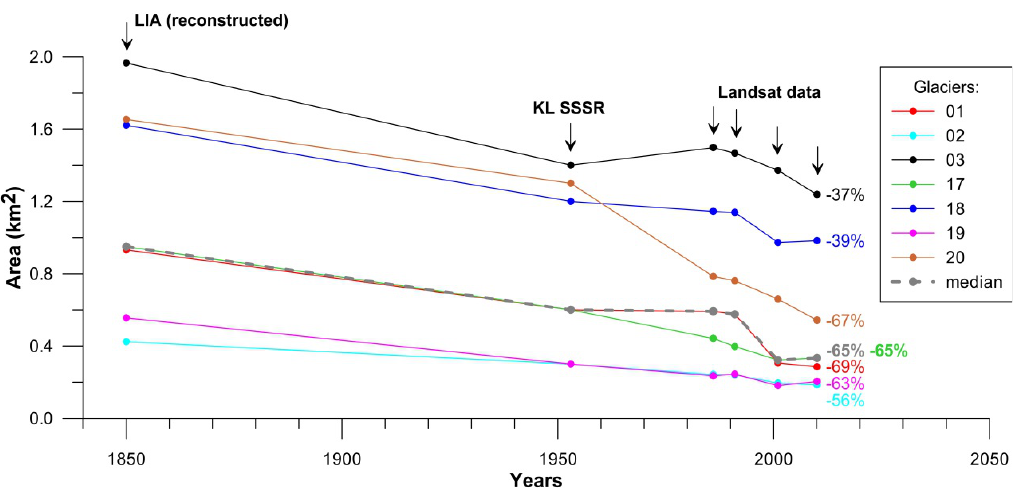
Figure 3. Absolute area changes from the end of the Little Ice Age to 2010 for seven studied glaciers and a median glacier. Number of glaciers corresponds to those referred in Figure 1. The percentages show the relative ice change since the Little Ice Age (LIA). “KL SSSR” means the data of the Catalogue of glaciers of the USSR [7].